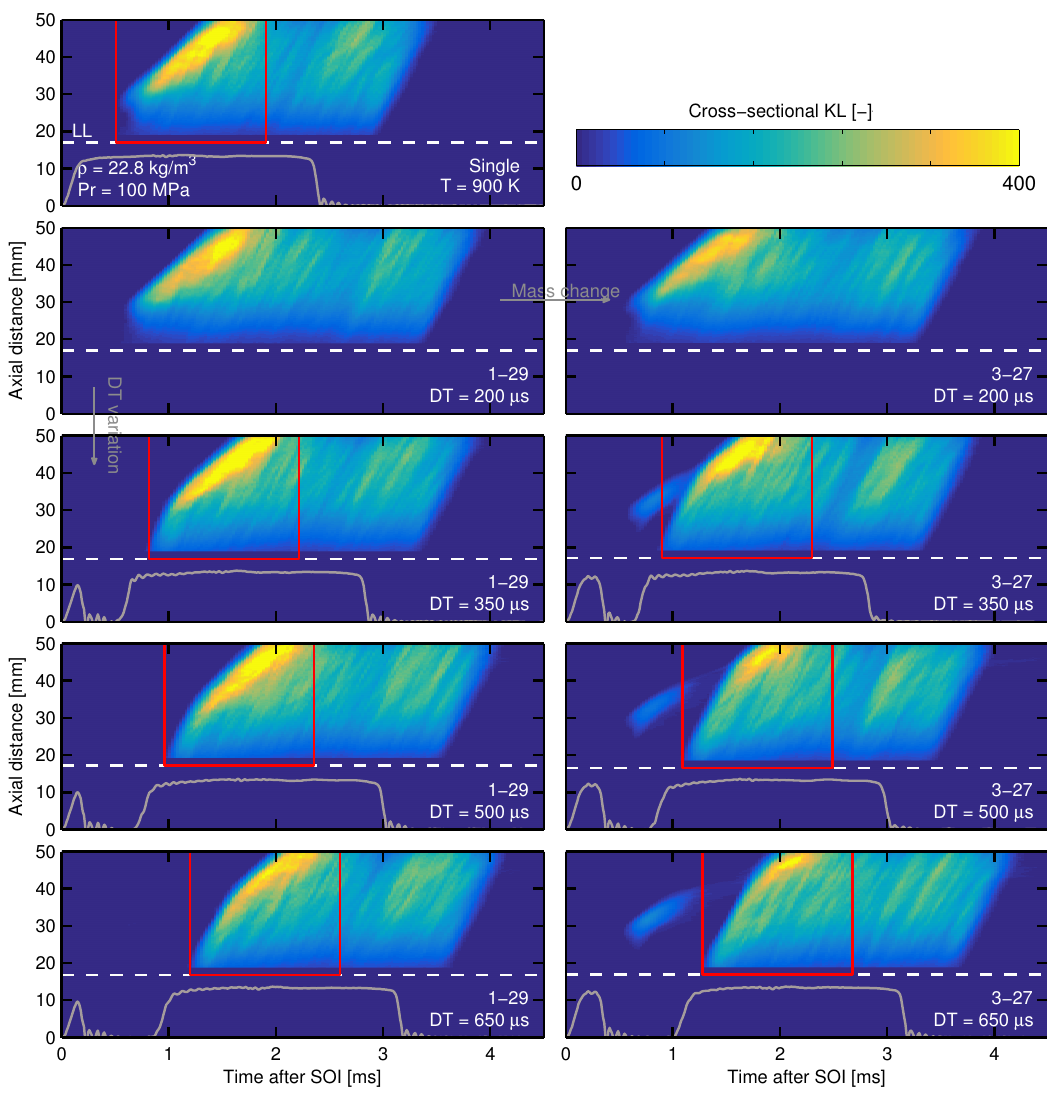
Figure 14. Evolution of the cross-sectional KL at each axial distance for pilot-main strategies for a rail pressure of 100 MPa, a chamber density of 22.8 kg · m − 3 and temperature of 900 K. The dashed white lines depict the liquid length. Red dashed rectangle represent a reference for the Table 4 of the first 1.4 ms after the SOC of the main for dwell times of 350 µ s and the single injection. The mass flow pulses [13] are plotted when they decoupled. Gray arrows represent the direction of the variable changed for